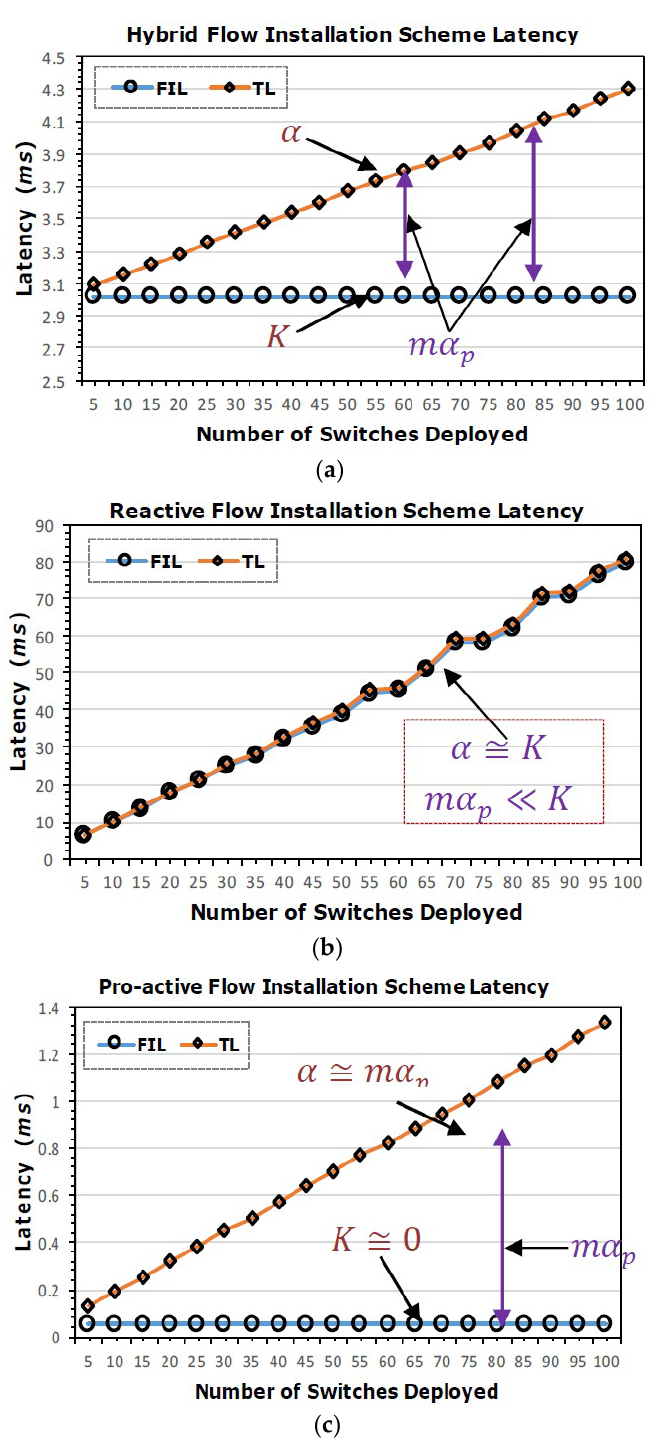
Figure 6. Mean Latency for varied number of switches ( a ) Hybrid ( b ) Reactive ( c ) Pro-active. FIL—Flow Installation Latency, TL—Total Latency.